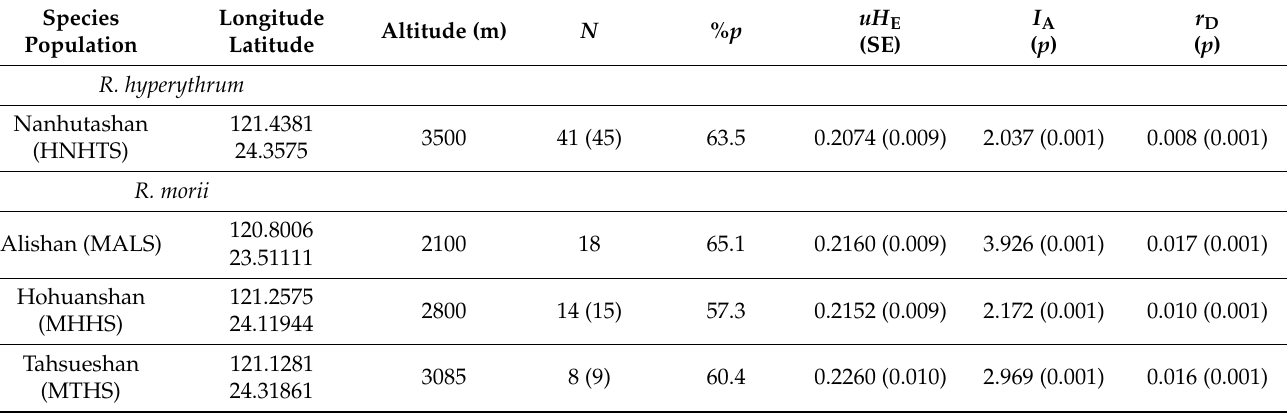
Table 1. Site properties and genetic parameters of sampled populations of the Rhododendron pseu- dochrysanthum complex estimated based on the total AFLP